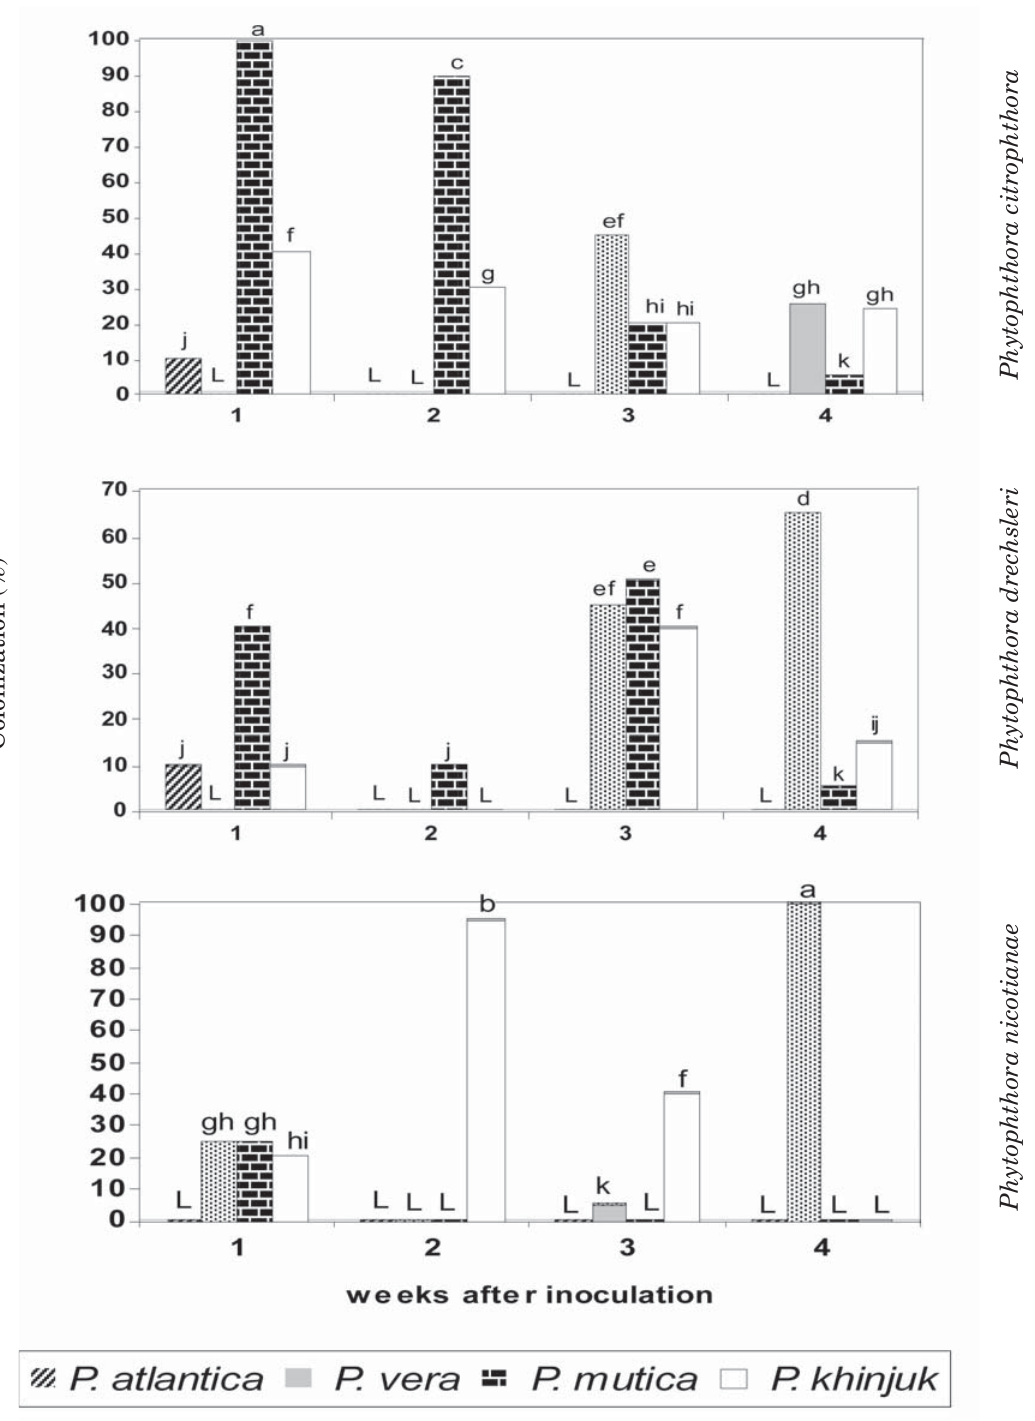
Fig 1. Population changes of Phytophthora spp. in the root zone of Pistacia spp. during 4 weeks under greenhouse conditions. Means followed by the same letter are not significantly different according to Duncan , s multiple range test ( P ≤